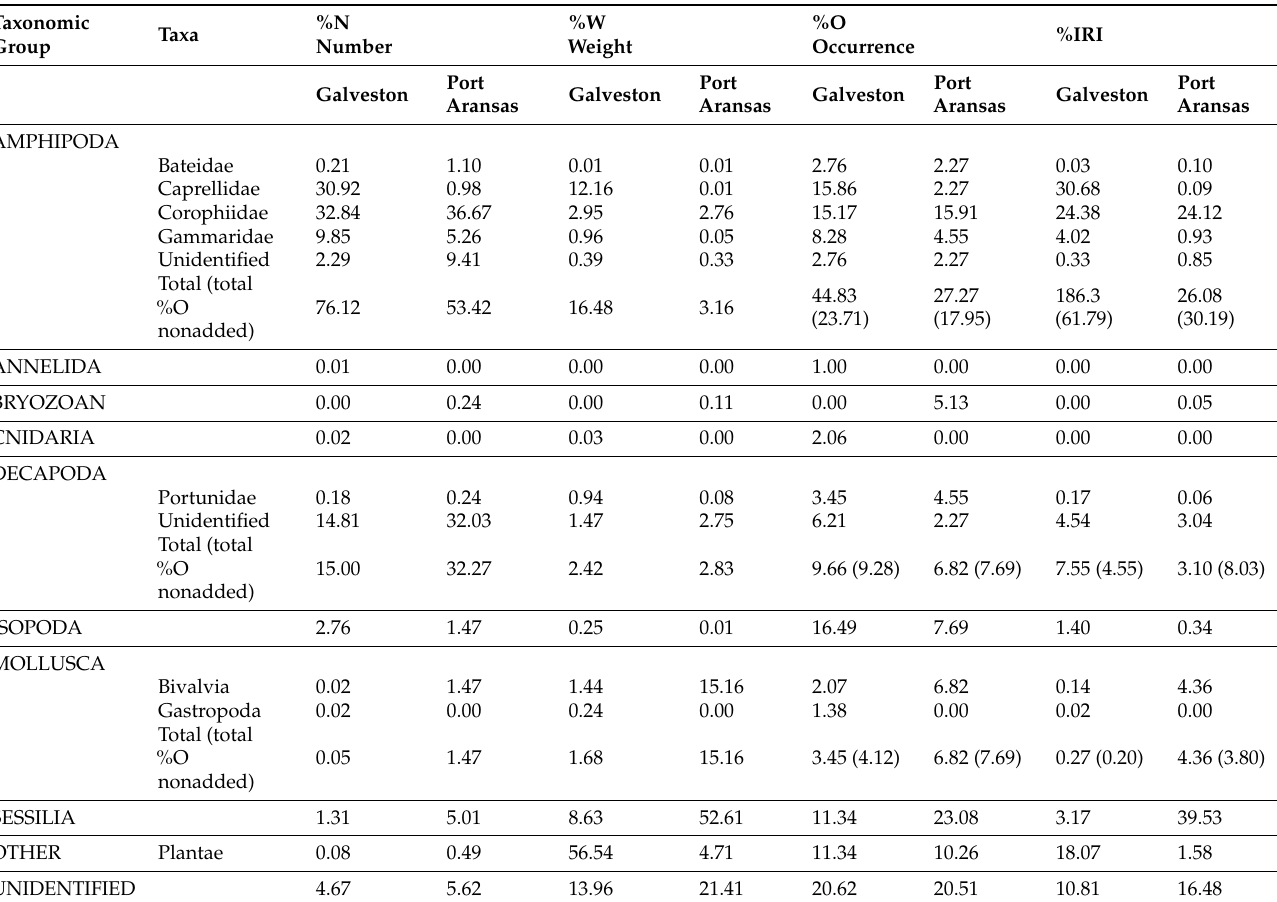
Table 1. IRI table showing percent number (%N), percent weight (%W), percent occurrence (%O), and percent index of relative importance (%IRI) of prey items found in sheepshead stomachs from Galveston, TX ( n = 23) and Port Aransas, TX ( n = 18). Values for %O in parentheses were observed nonadded values (i.e., corresponding with a particular food type, not the sum of its components). Values for IRI and %IRI in parentheses were calculated using observed nonadded %O